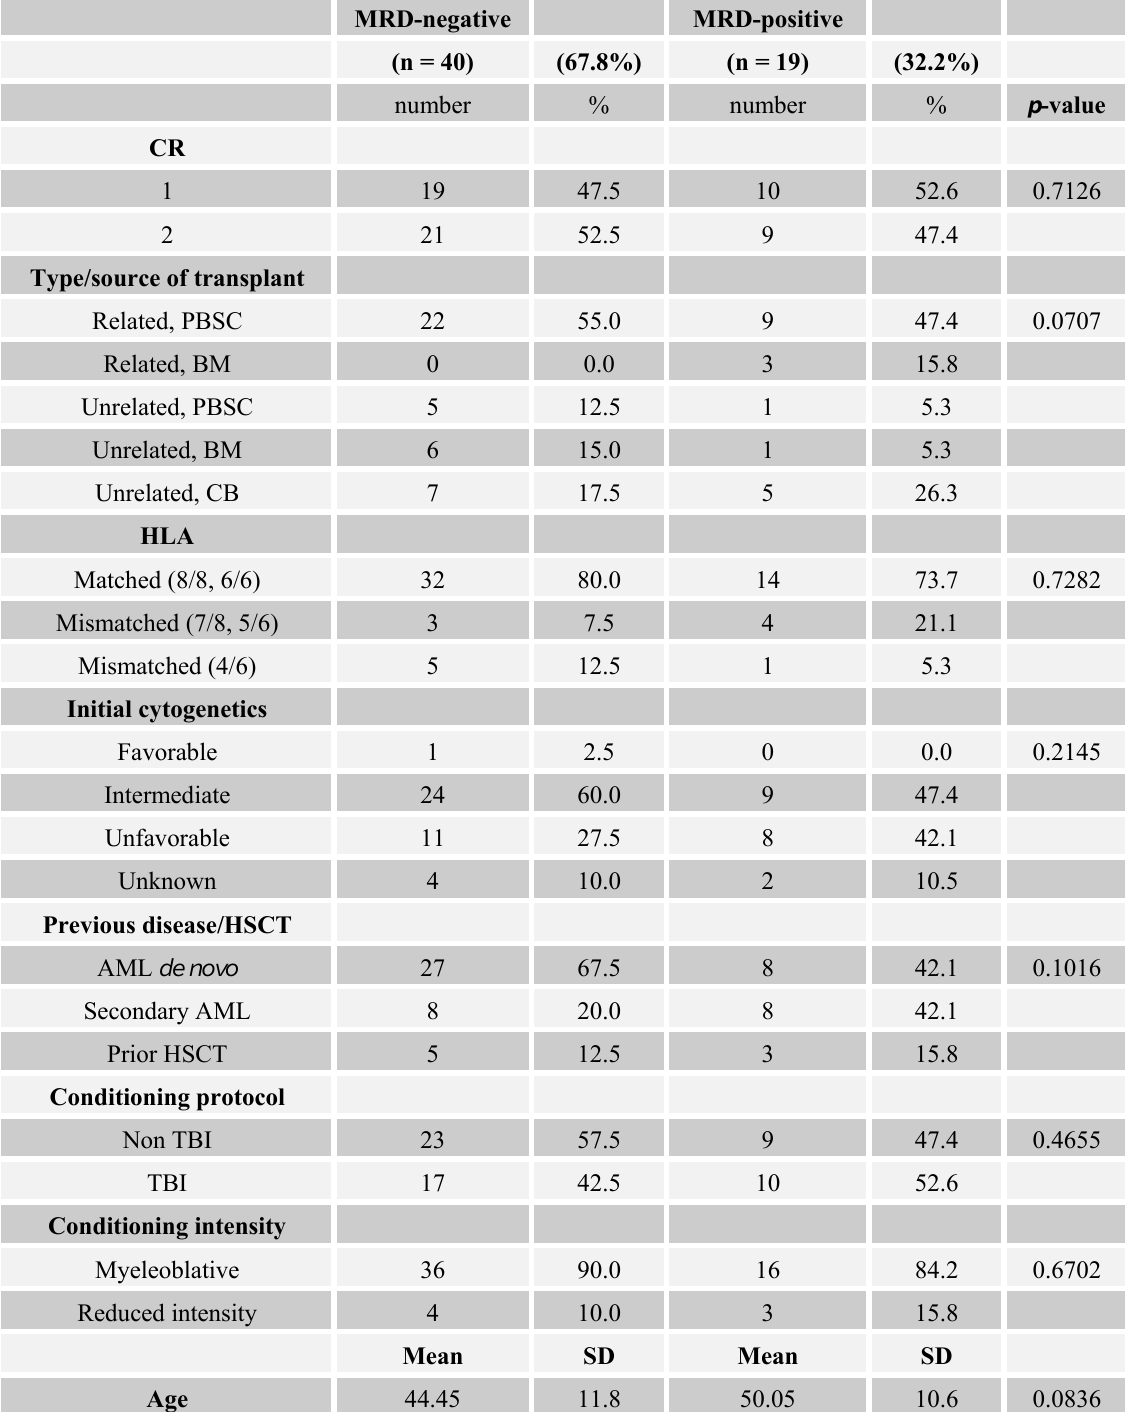
Table 3. Comparisons of risk factors between